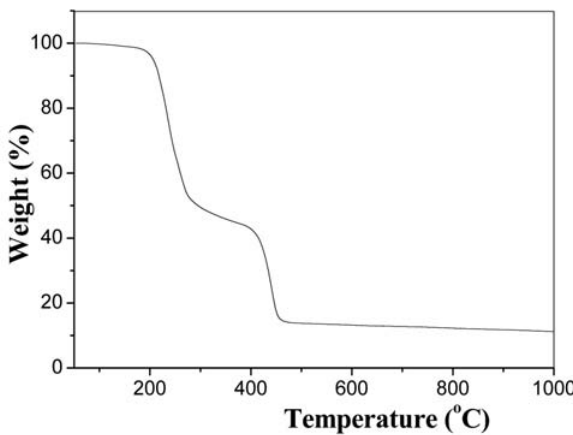
Figure 3. TG curve of the